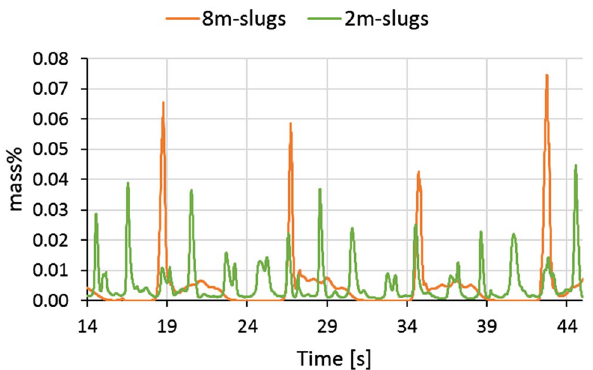
Fig. 10 Mass % gas flowing through OL for 8- and 2-m slugs (Case 3.1 and Case